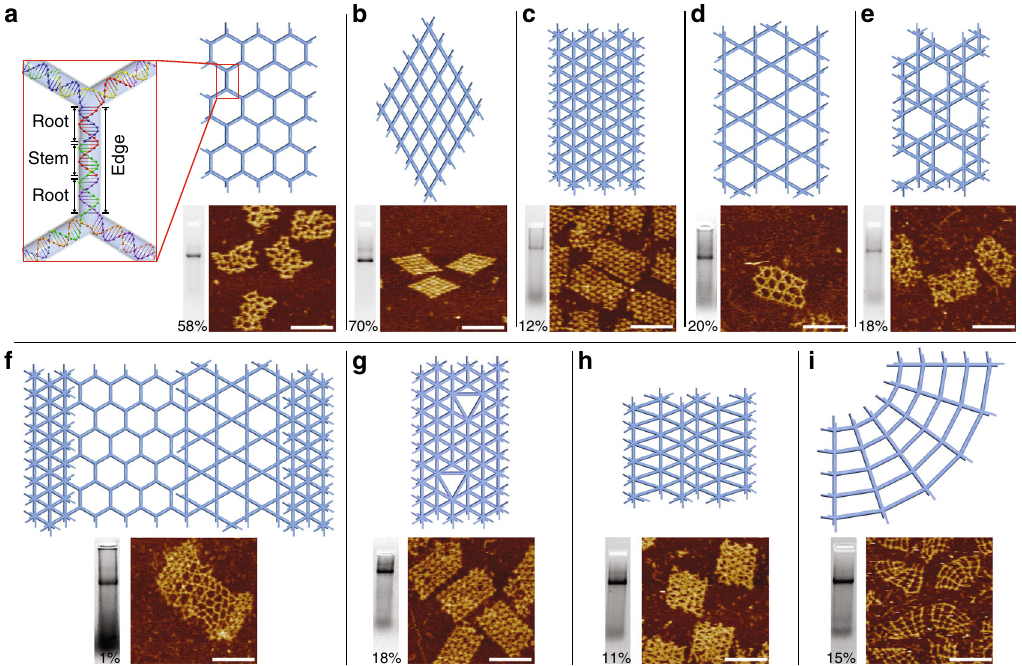
Fig. 2 Two-dimensional (2D) wireframe arrays of different tessellation patterns. a Hexagonal tessellation pattern with 3-arm verties. Inset shows a strand diagram of a typical edge (a stem domain sandwiched by two root domains). b Square tessellation pattern with 4-arm vertices. c Triangular tessellation pattern with 6-arm vertices. d Trihexagonal tessellation pattern with 4-arm vertices. e Snub trihexagonal tessellation pattern with 5-arm vertices. f Chimeric pattern with individual blocks composed of 3-arm, 4-arm, and 6-arm vertices. g , h Two irregular triangular patterns with 6-arm vertices. i Cobweb-like pattern with 4-arm vertices. Top: schematic diagrams of the wireframe structures; bottom: native agarose gel electrophoresis results (bottom left, numbers indicate assembly yields) and AFM images (bottom right, scale bars: 100